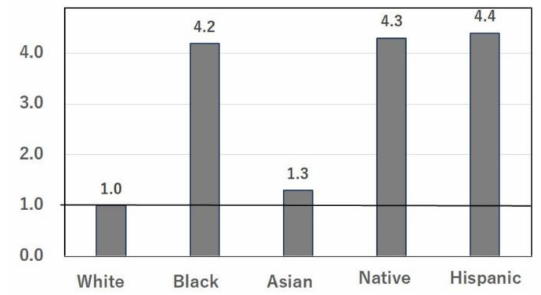
Figure 1. Number of inpatients with COVID-19 according to ethnicity in the U.S. Numbers are relative to the number of Whites as 1. Data were obtained from a cross-sectional study: Centers for Disease Control and Prevention. COVID View. Key updates were for week 43, ending 24